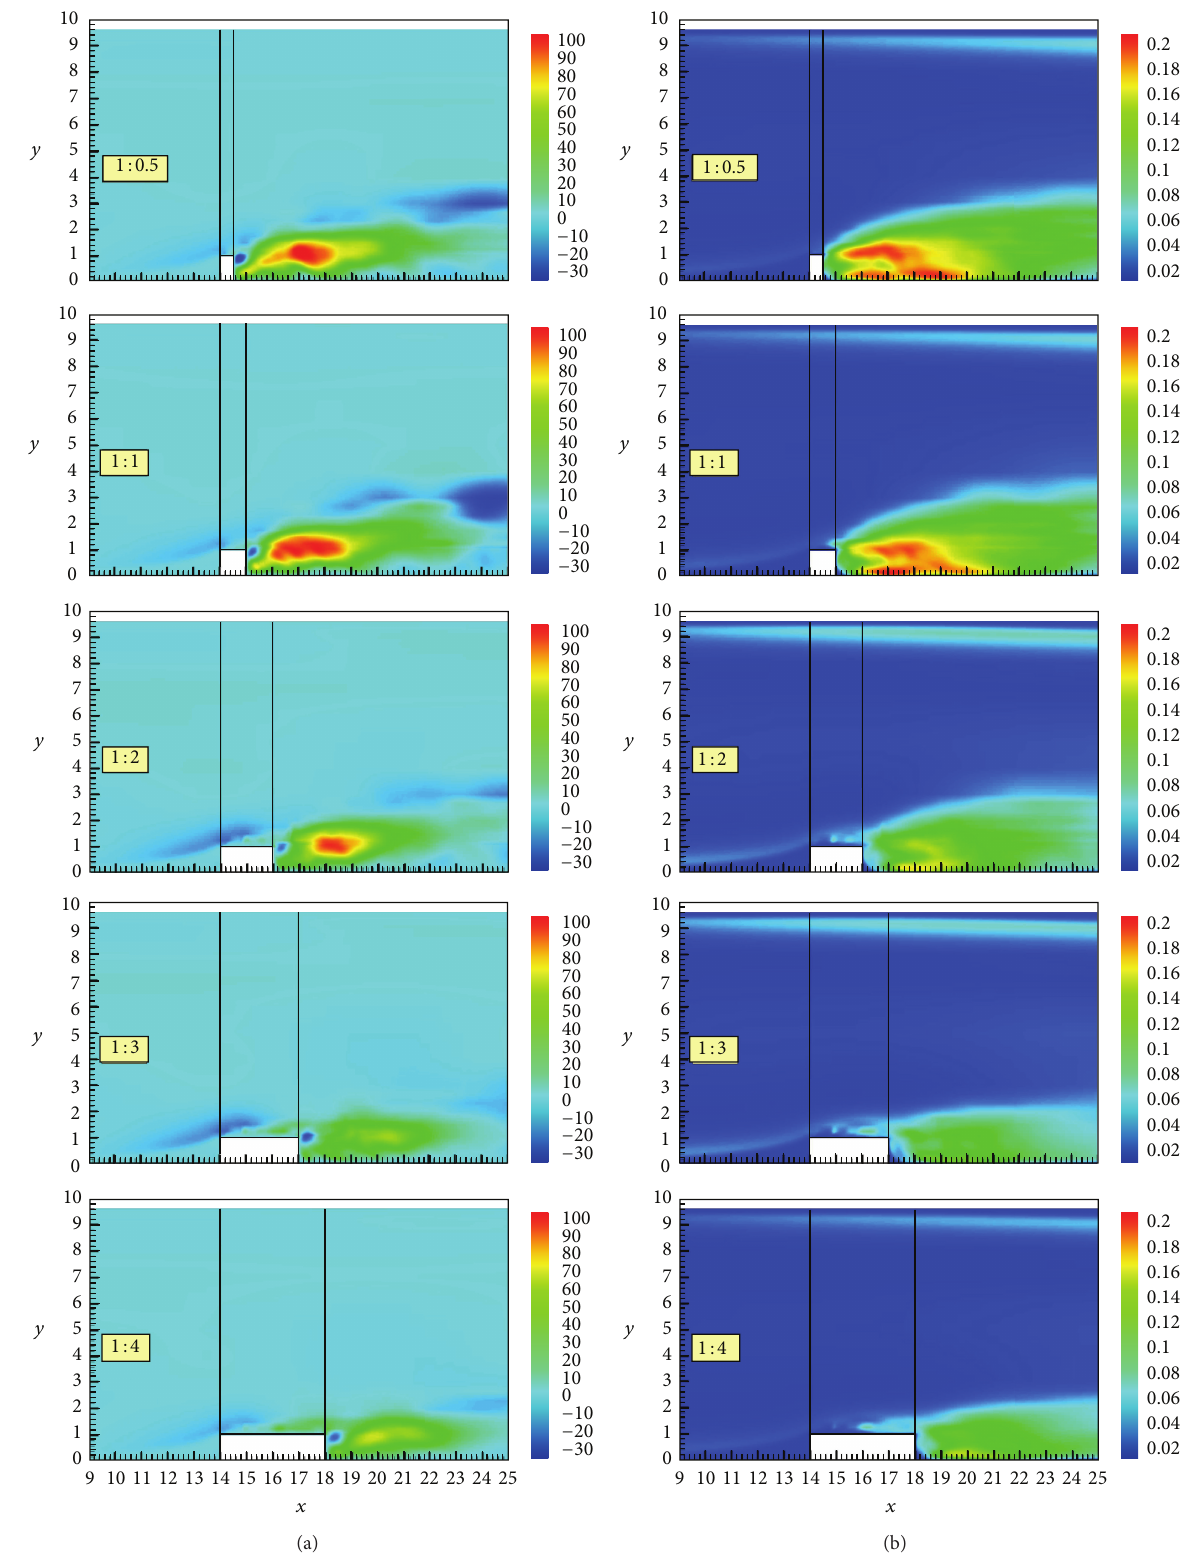
Figure 8: Color-coded plots of Reynolds stresses (a) and turbulent kinetic energy